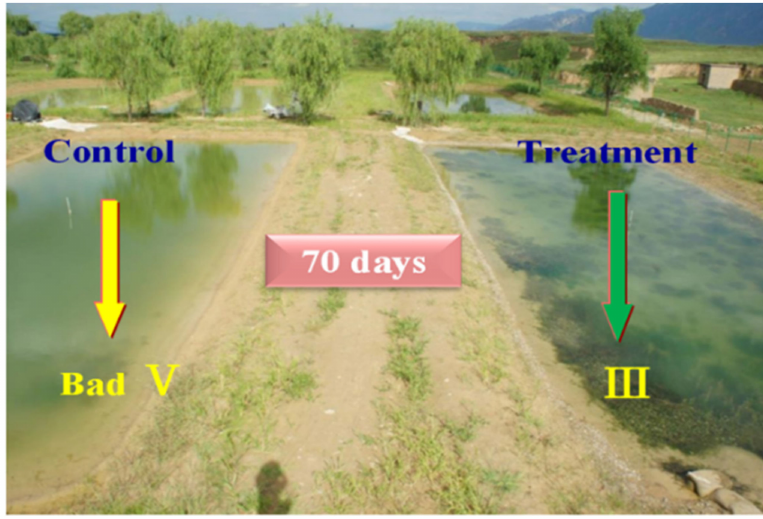
Figure 8. Control ( left ) and treatment ( right ) ponds at Cetian Reservoir.